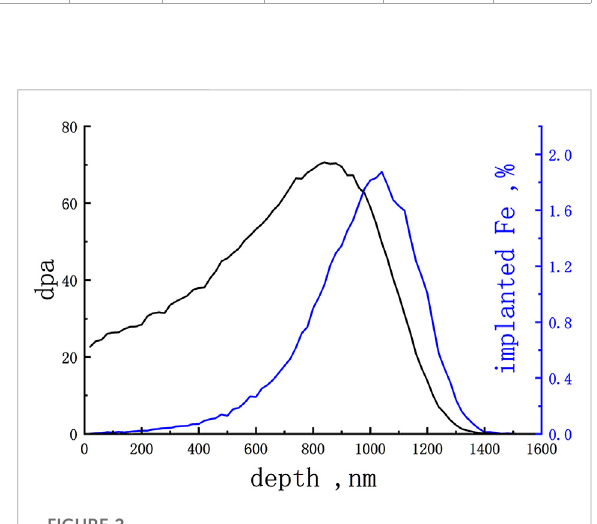
FIGURE 2 Damage (dpa) and implanted Fe ions distribution (%) along depth calculating by